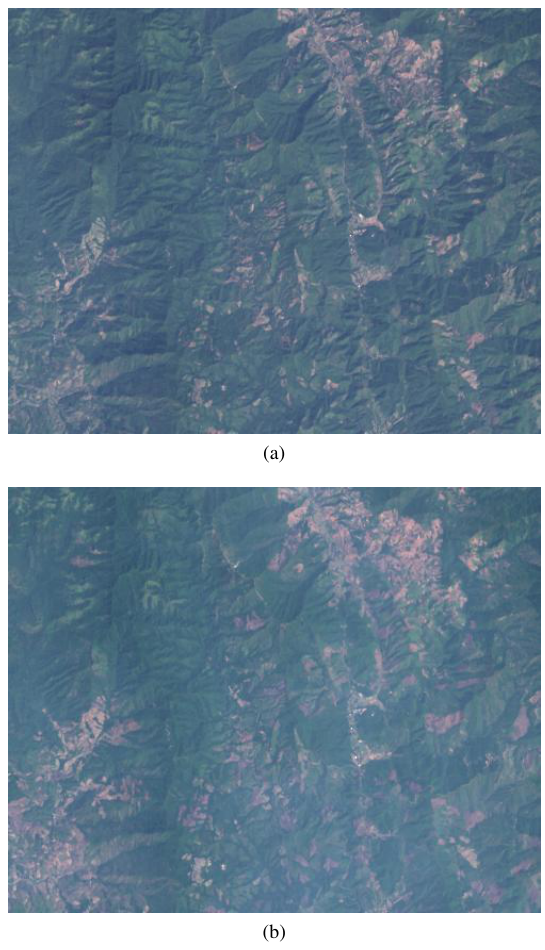
Figure 2: Landsat 8 imageries used for comparing the perfor- mance of the proposed rotation sampling method and uniform rotation angle sampling.